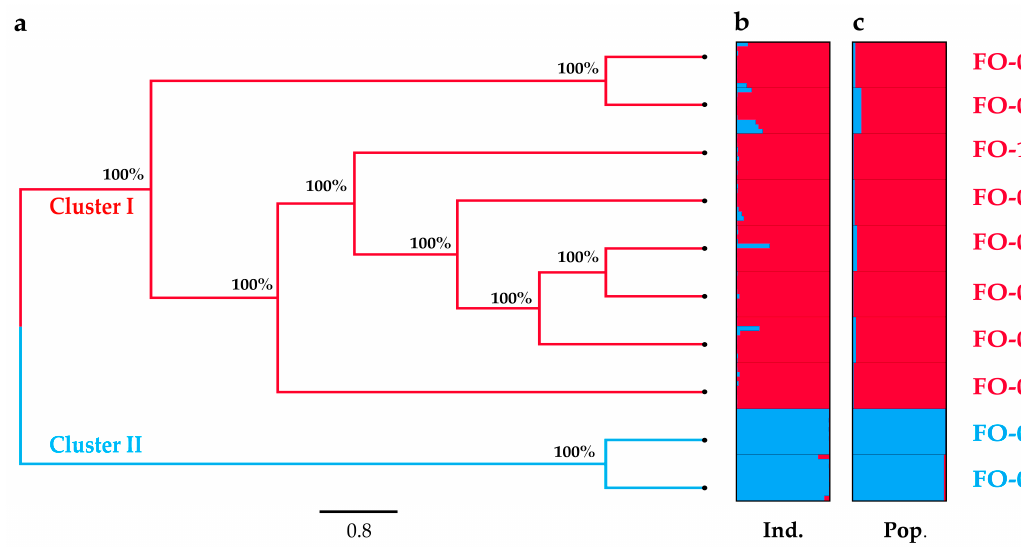
Figure 1. Cluster analysis for F. ovina (( a ) UPGMA (unweighted pair-group method with arithmetic means) tree for 10 populations, ( b ) structure analysis for 100 individuals, ( c ) structure analysis for 10 populations). Two colors represented different potential genetic backgrounds.